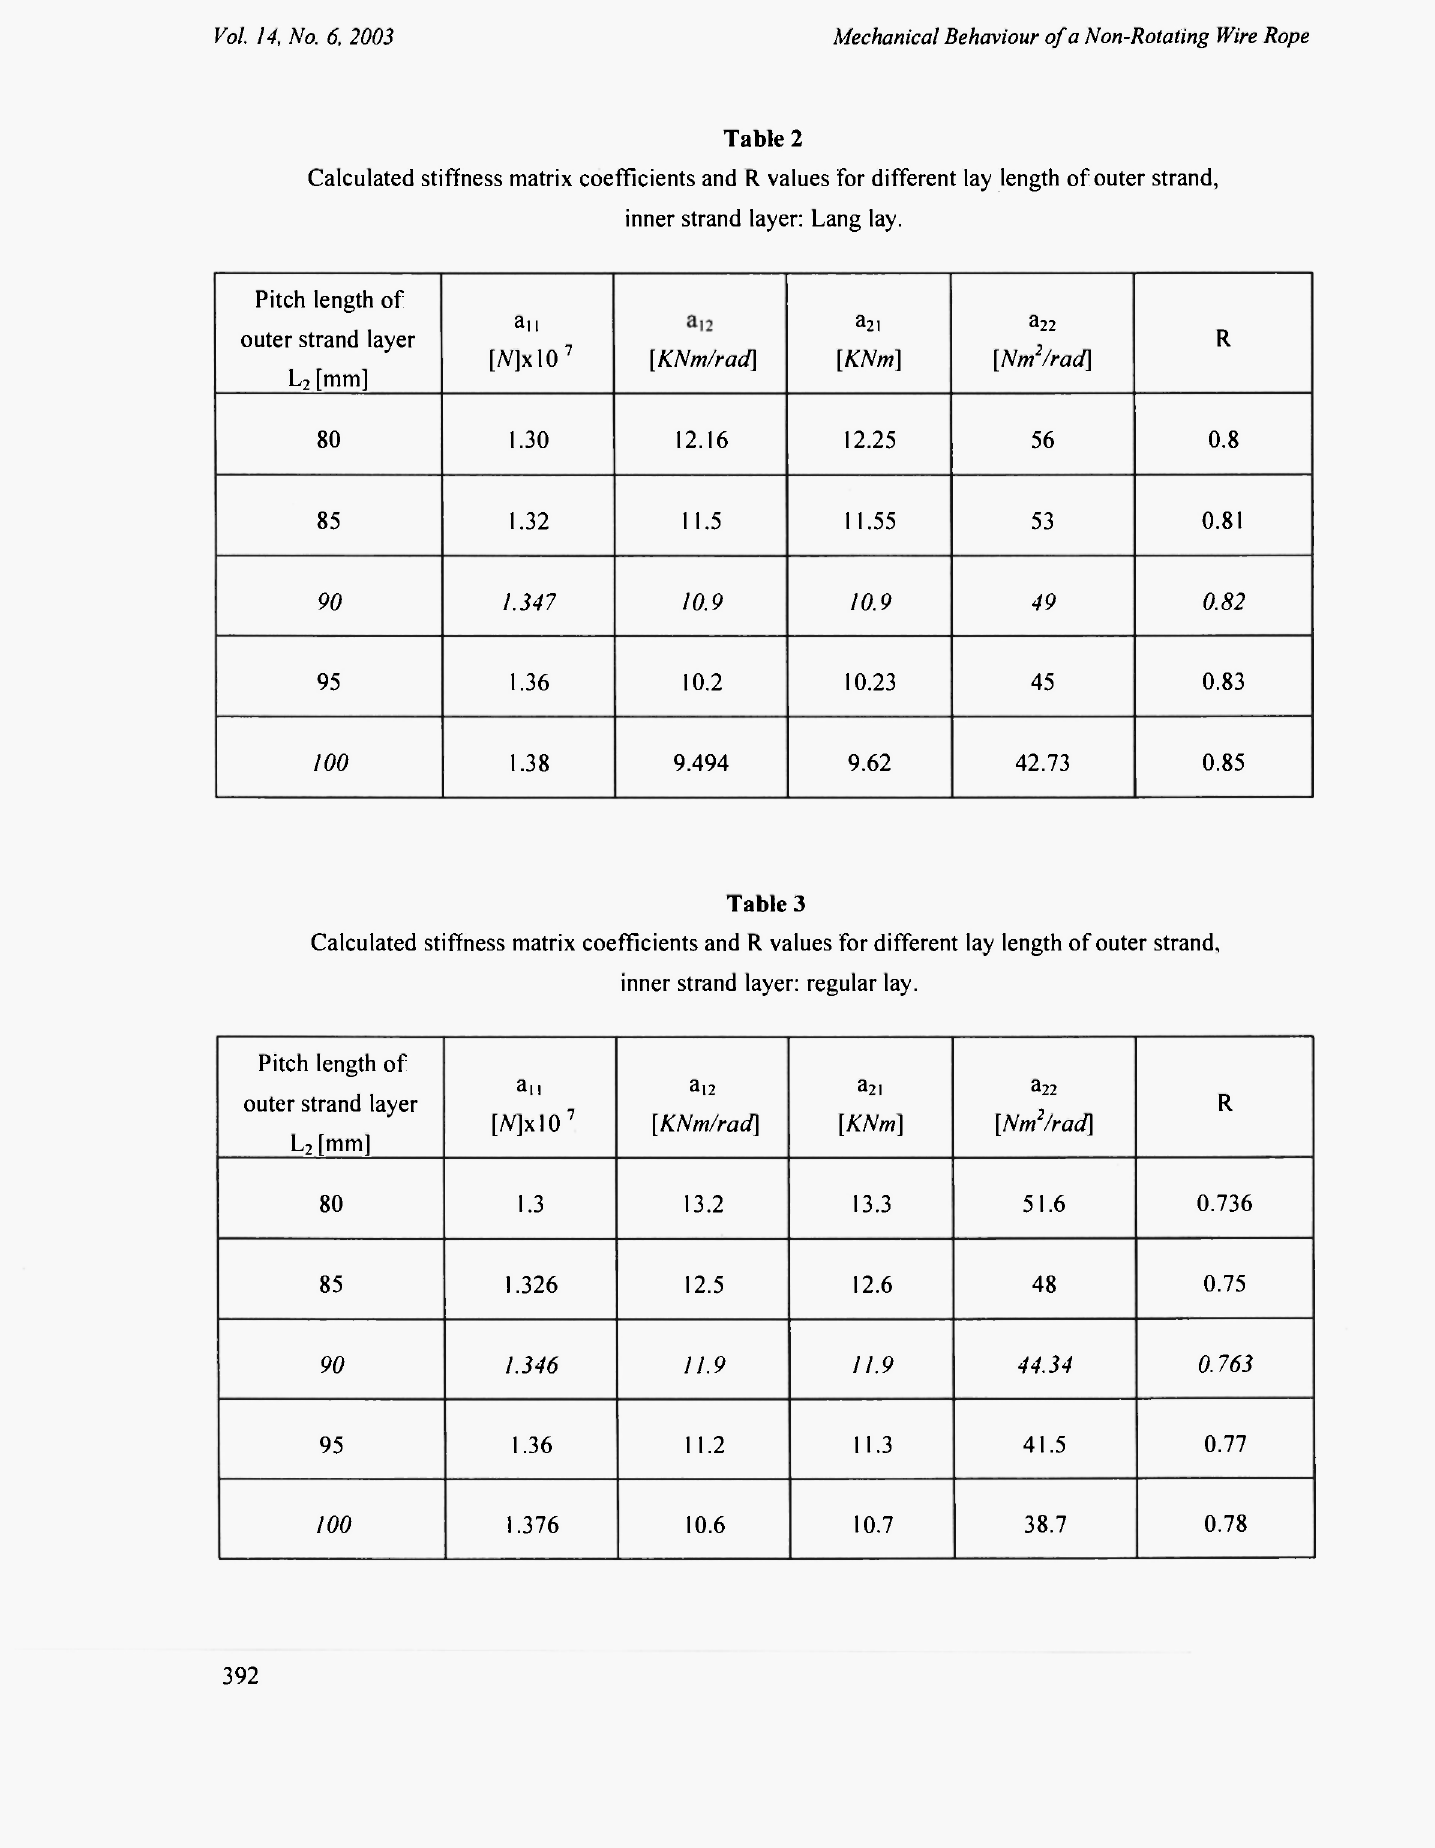
Calculated stiffness matrix coefficients and R values for different lay length of outer strand, inner strand layer: Lang lay.